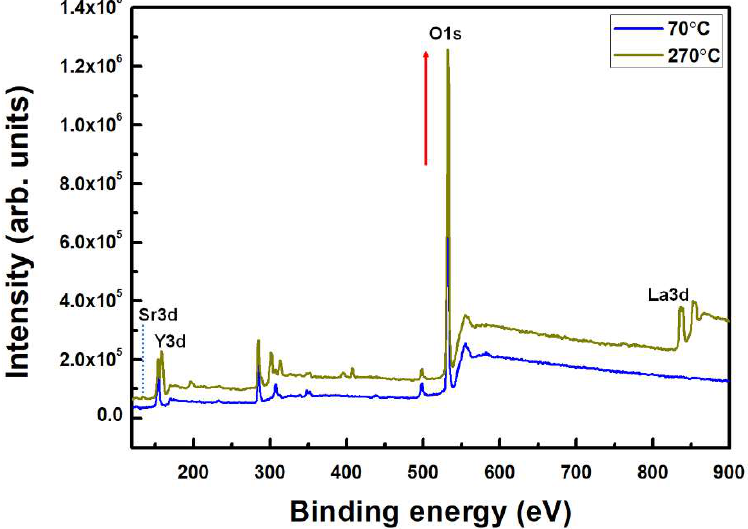
Figure 2. XPS spectra over a wide scan range for the brush-coated LaYSrO films cured at 70 and 270